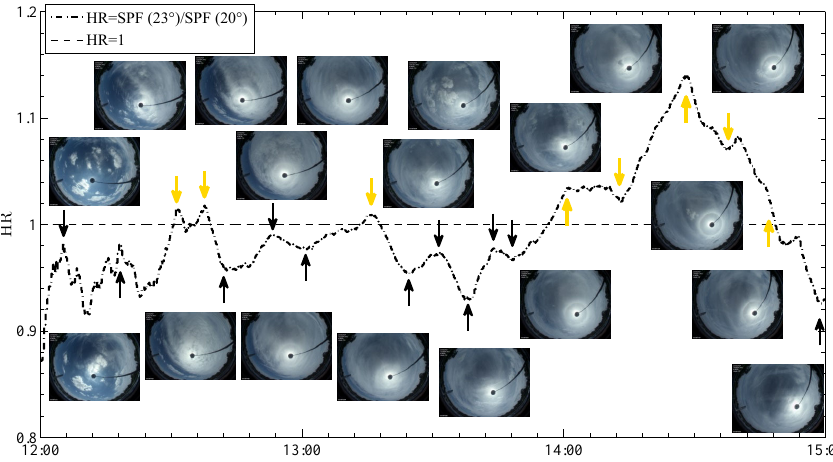
Figure 12. As Fig. 10, but HR time series from 7 July 2016 between 12:00 and 15:00.